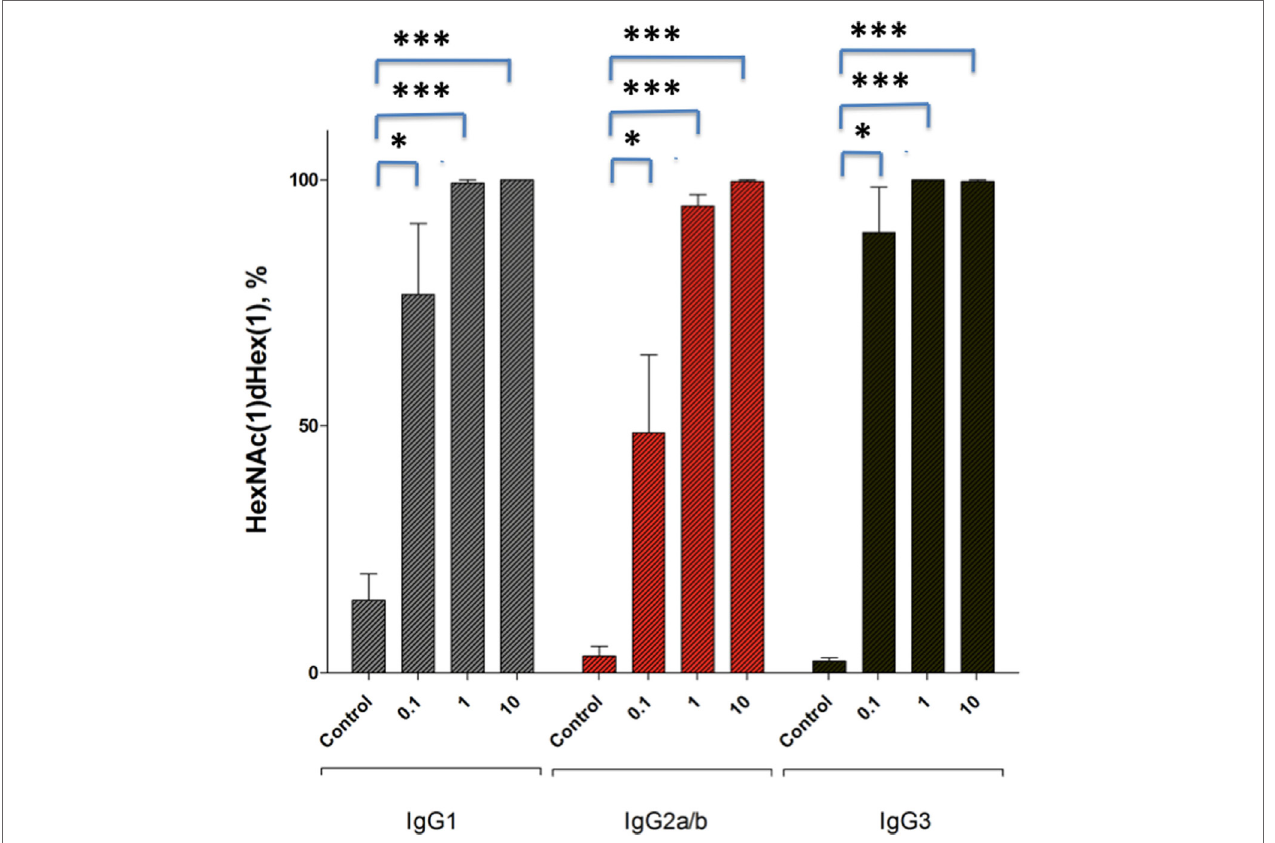
FigUre 5 | Relative abundance of dHex-HexNAc after endo- β - N -acetylglucosaminidase (EndoS) treatment in vivo . Male (BALB/c × B10.Q) F1 mice ( n = 12) were injected with GST- recombinant protein (control), 0.1 µg, 1 µg, or 10 µg of GST-EndoS. Serum samples were collected before and 18 h after the injection. Even at 0.1 µg of EndoS injection the majority of the found glycopeptides, for all IgG types are the truncated dHex-HexNAc variants. The bar graph shows mean ± SEM of the relative abundance of dHex-HexNAc compared with other Fc-glycopeptides. dHex(1)-HexNAc (1), dHex (1)Hex (3)HexNac (4), dHex (1)Hex (4)HexNAc (4), dHex (1)Hex (5)HexNAc (4) sugars present on IgG1 (EEQFNSTFR), IgG2b (EDYNSTIR)/IgG2a (EDYNSTLR), and IgG3 (EAQYNSTFR) peptides, respectively. Glycopeptides were analyzed using mass spectrometry. * p < 0.05; **** p <